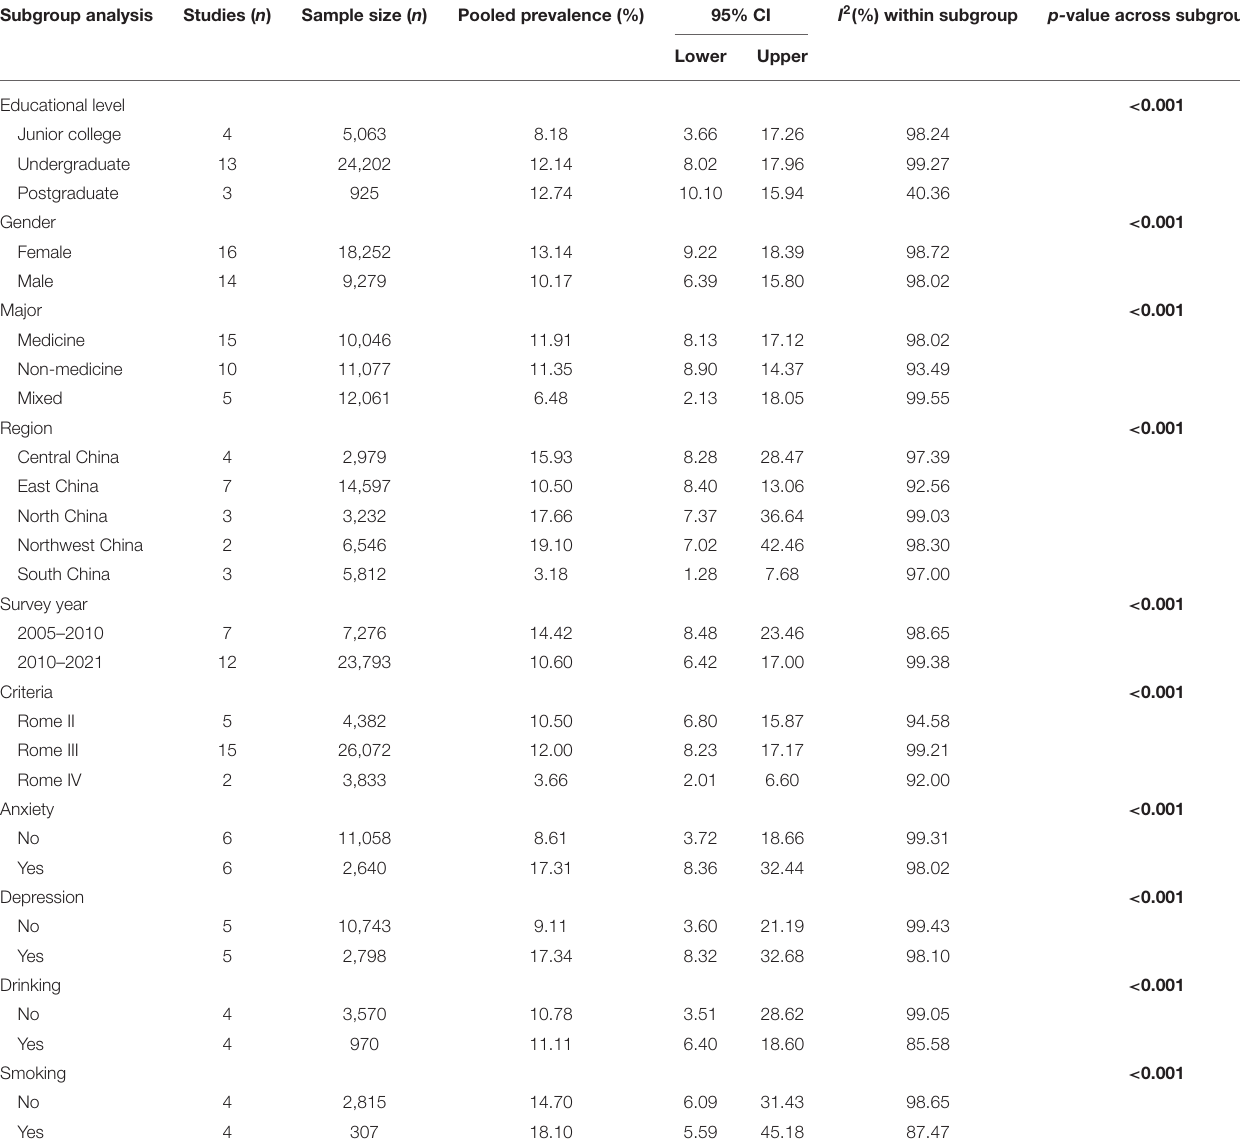
TABLE 2 | Subgroup analyses of the pooled prevalence of IBS. Subgroup analysis Studies ( n ) Sample size ( n )